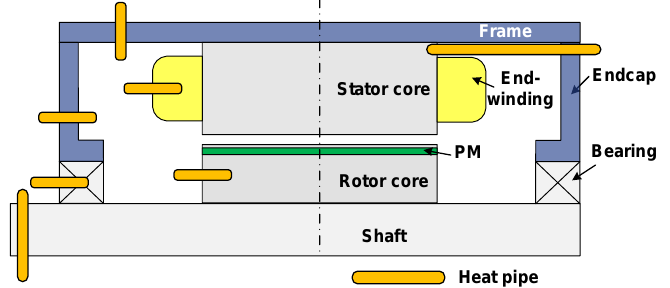
Figure 7. Schematic diagram of possible applications of heat pipes in electrical machines [31].